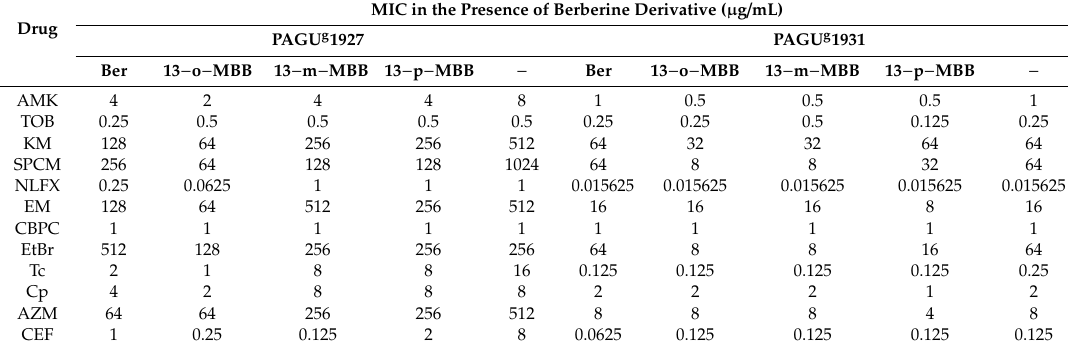
Table 3. Increase in sensitivity to antibiotic resistance due to 13 − o − MBB and its regioisomers. MIC in the Presence of Berberine Derivative ( µ g / mL) Drug PAGU g 1927 PAGU g 1931 Ber